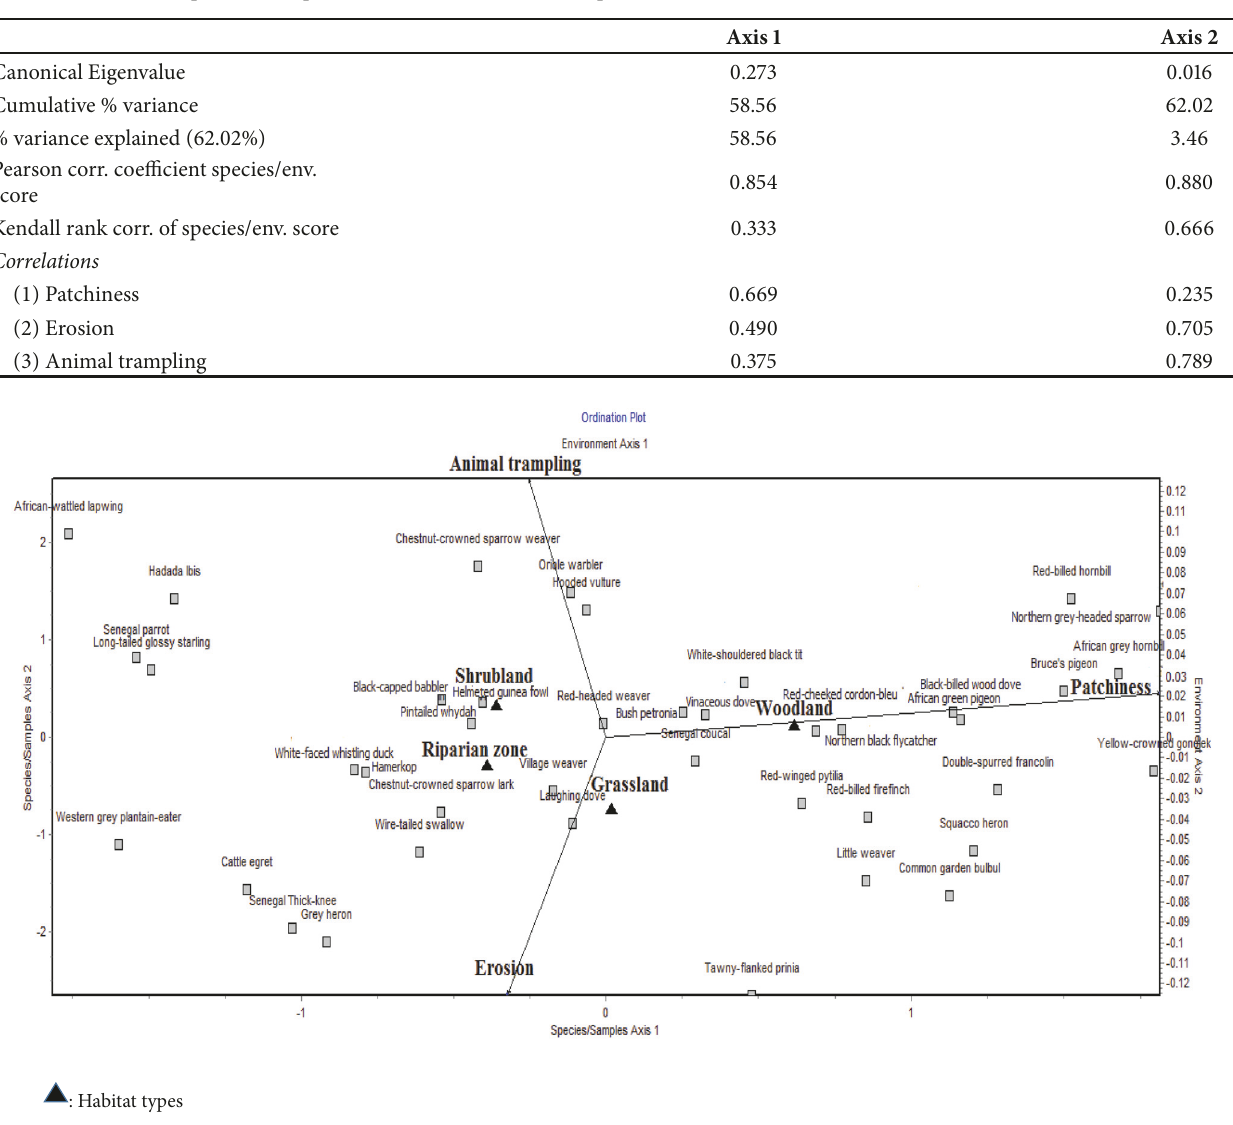
Table 5: Summary of canonical correspondence analysis (CCA) of birds showing the levels of correlation between axes and environmental gradients, variance of species, and species-environmental relationships (wet season).